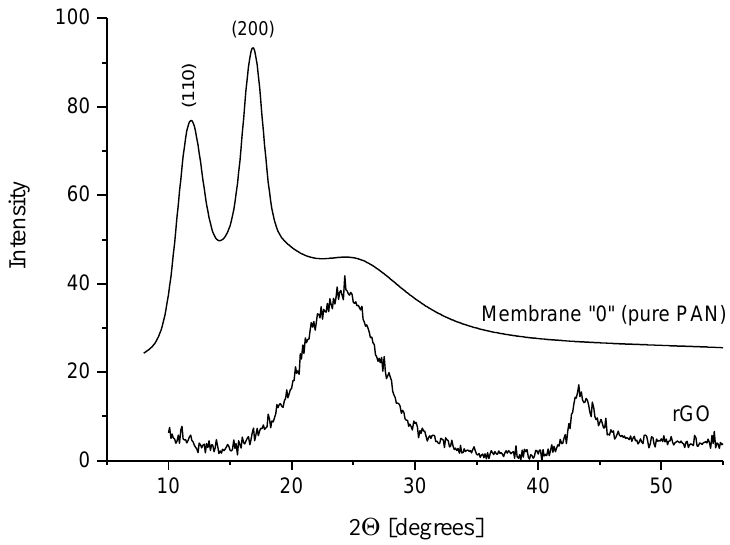
14 of 19 Figure 8. FTIR spectra of the composite rGO/PAN membranes ( B , D , F , H ), the pure PAN membrane and the pure rGO. 3.3.2. WAXS The morphology of all membranes was investigated with X-ray diffraction. The membrane “0”